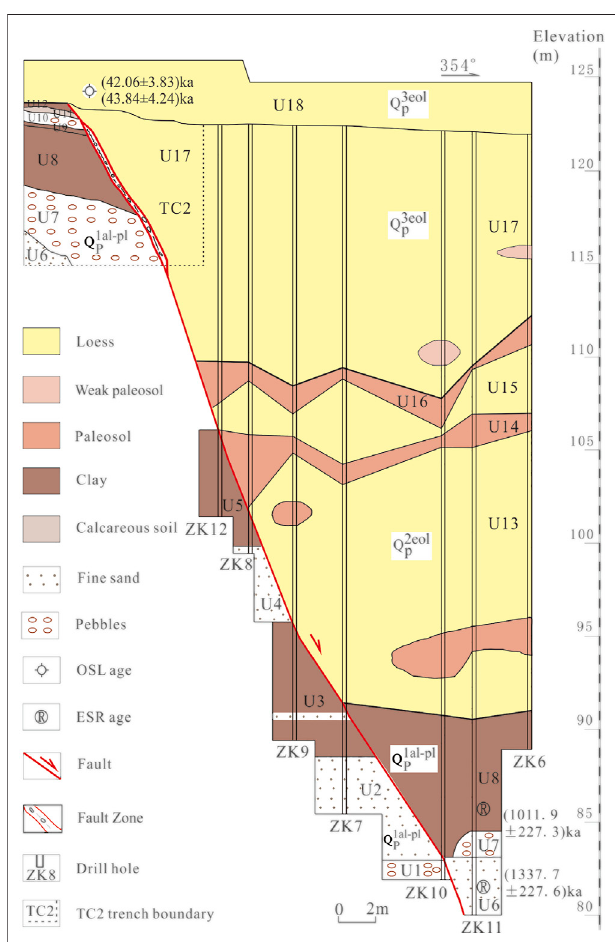
FIGURE 4 | The comprehensive interpretation map of trench and composite drilling geological